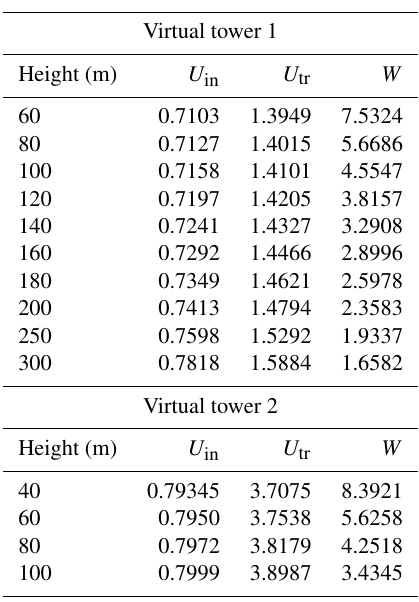
Table 5. Error analysis on the retrieval of the 3-D wind velocity from triple-Doppler lidar measurements as a function of the lidar setup for the various virtual towers and heights.